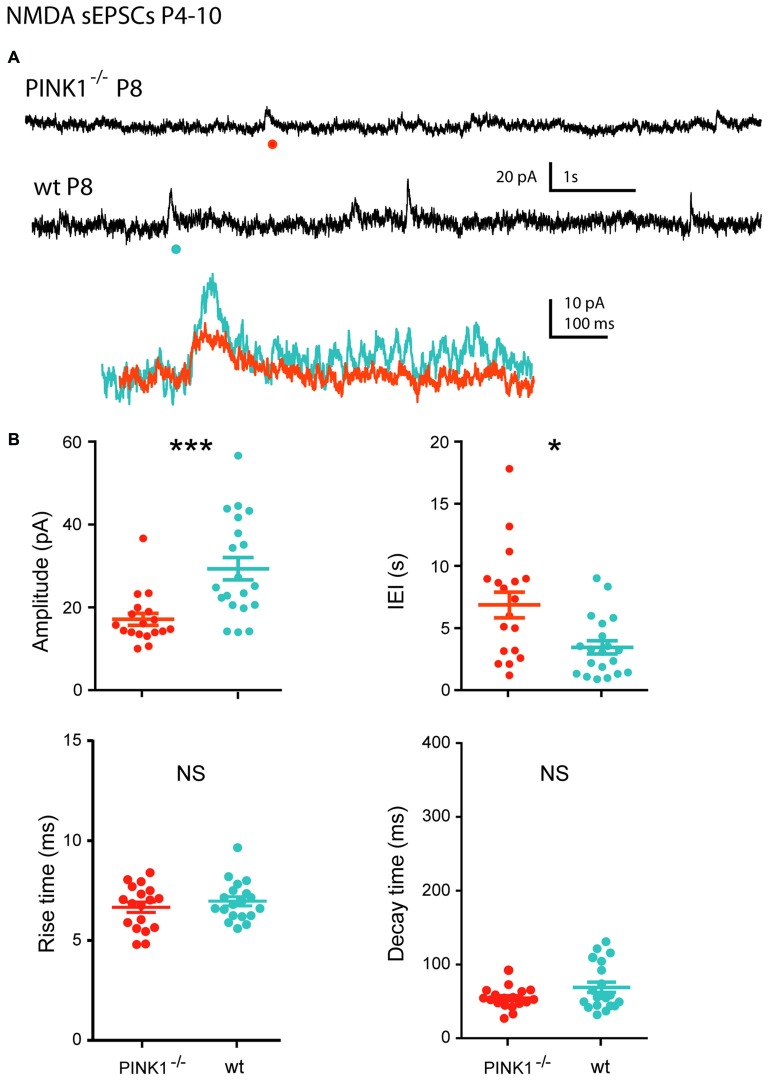
Single NMDA sEPSCs in immature (P4–10) pink1−/− SNc DA neurons and comparison with age-matched wt SNc DA neurons. (A) Voltage-clamp recordings of NMDA sEPSCs from a P8 pink1−/− (red) and a P8 wt (blue) SNc DA neuron in the continuous presence of gabazine (5 μM) and NBQX (10 μM) at VH = +40 mV. The NMDA events indicated by a dot are enlarged and superimposed in the inset. (B) Quantification and statistical comparison of the amplitudes and IEIs and of the rise and decay times of P4–10 pink1−/− (n = 18) and wt (n = 20) NMDA sEPSCs, as indicated.